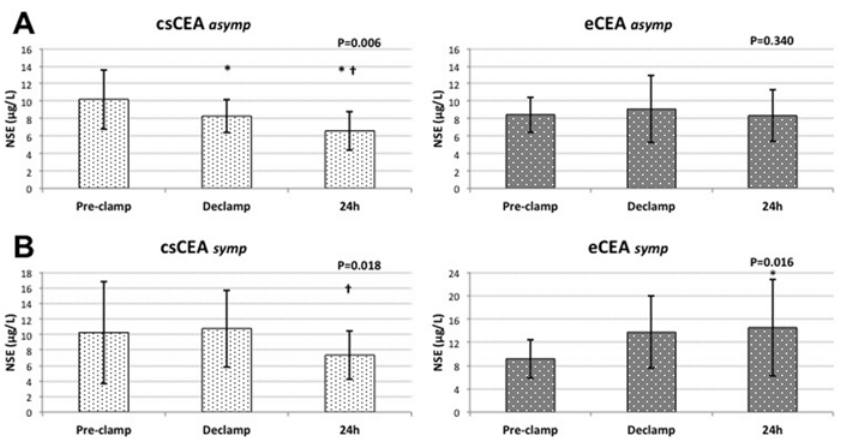
Fig 4. Variations of NSE serum concentrations in relation to the symptomatology of carotid disease. (A) asymptomatic patients; (B) symptomatic patients; * — significant compared to pre-clamp (P < 0.05); † - significant compared to declamp (P <